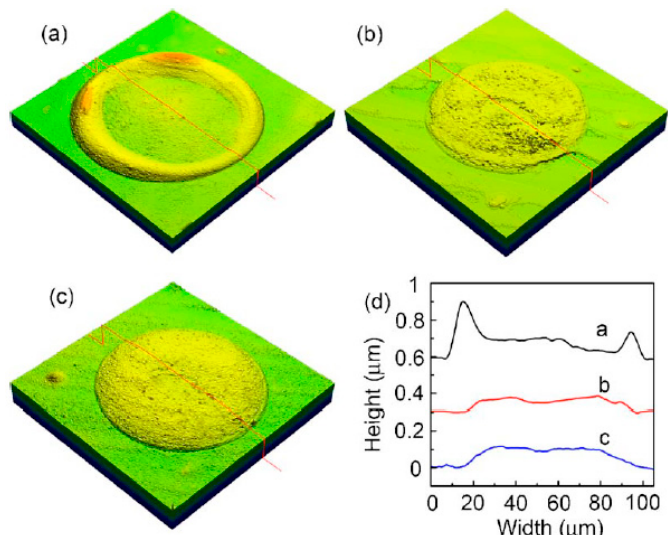
Figure 4. 3D images of ink-jet printed single dots of Ag NPs with different ethylene glycol as carrier solutions: ( a ) 0 wt.%; ( b ) 16 wt.%; ( c ) 32 wt.%; and ( d ) corresponding 2D profile. (Reproduced with permission from [14]. Copyright 2006 AIP Publishing.